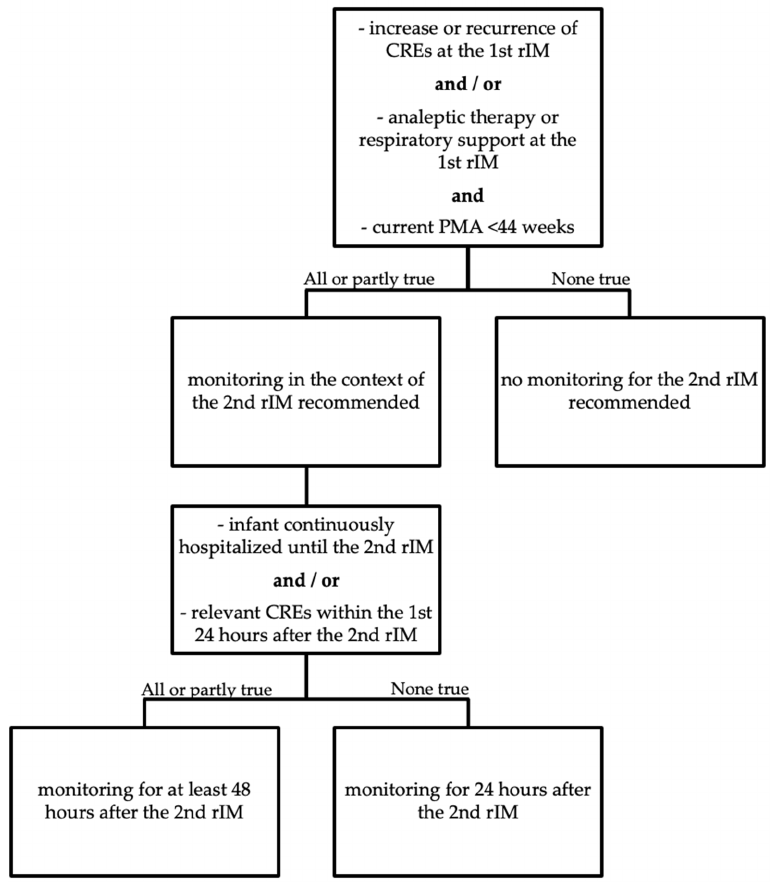
Figure 3. Flow chart of monitoring recommendations for preterm infants in the context of the 2nd rIM. Regression analyses defined a PMA of 43.5 weeks at the time of the second rIM as the age at which immunization-related CRE-ts will cease. This is consistent with the re- ported age of approximately 43 weeks PMA at which the frequency of CREs in preterm infants has decreased to the level observed in term born infants [36]. This finding favors the reduced schedule in preterm infants with the second rIM given at a chronological age of 4 months as applied in the United States of America and Australia [3,4] and imple- mented for term infants in Germany and Canada (2 + 1 schedule) [1,5]. However, most efficacy studies of immunization in preterm infants so far have been based on a three-dose primary vaccination (3 + 1 schedule) [7,43,44]. Further studies are needed to adopt a 2 + 1 schedule for preterm infants. To our knowledge, this is the first prospective study to analyze CREs in response to the second rIM in preterm infants and to provide evidenced guidance for the monitoring of these infants with regard to the second rIM. Limitations are the restriction to only two study sites and one kind of vaccine combination which limits generalizability. Further- more, as the recordings were limited to 48 h after the immunization, no statement on any further CREs and the need for an extended monitoring thereafter can be made.